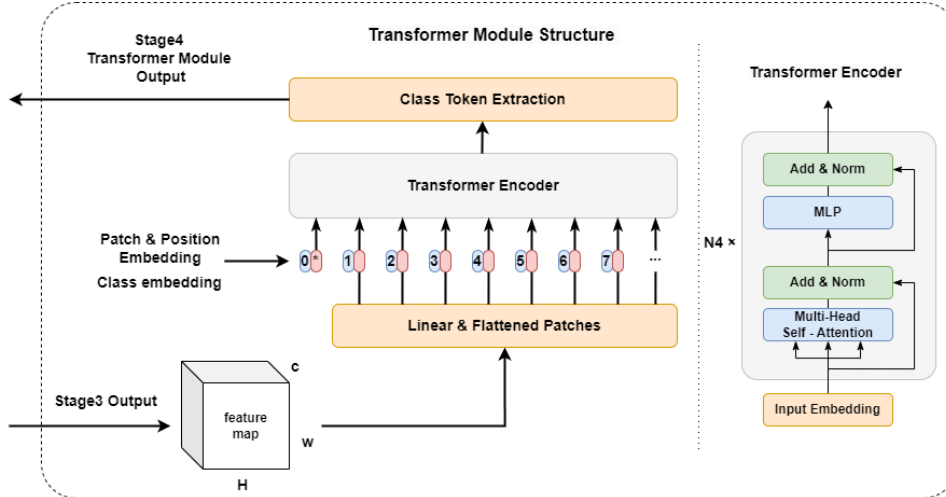
Figure 3. The structure of the Transformer